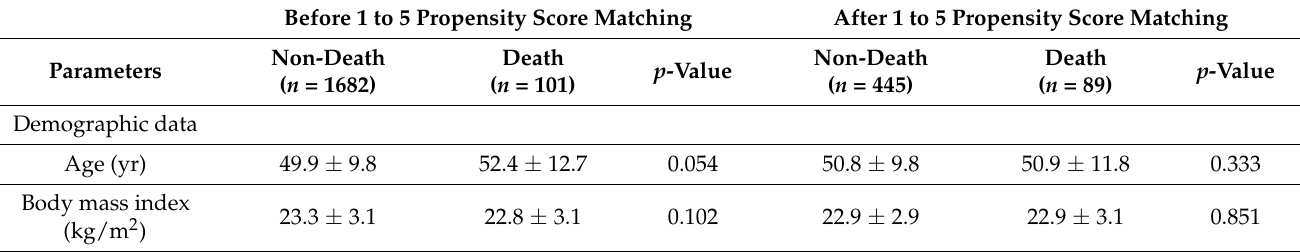
Table 2. Patient characteristics based on postoperative